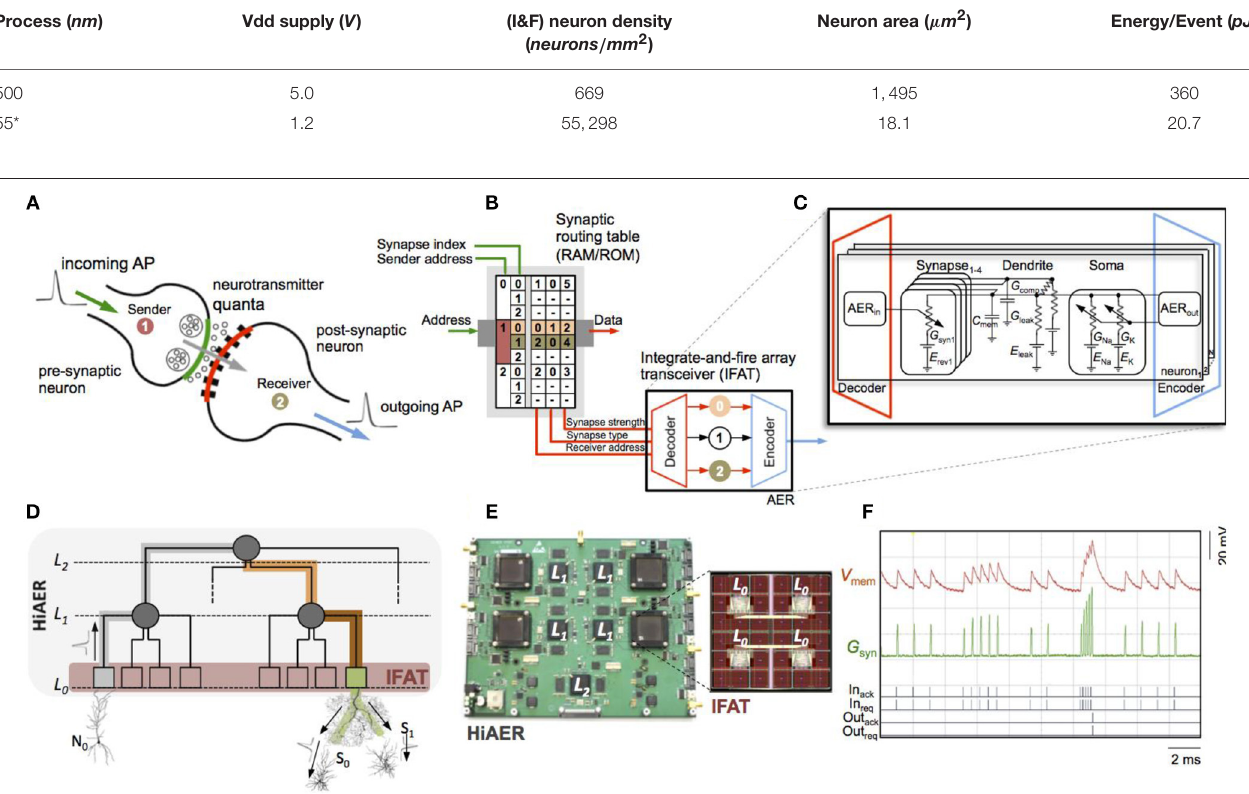
FIGURE 4 | Hierarchical address-event routing (HiAER) integrate-and-fire array transceiver (IFAT) for scalable and reconfigurable neuromorphic neocortical processing ( Broccard et al., 2017; Park et al., 2017). (A) Biophysical model of neural and synaptic dynamics. (B) Dynamically reconfigurable synaptic connectivity is implemented across IFAT arrays of addressable neurons by routing neural spike events locally through DRAM synaptic routing tables (Vogelstein et al., 2007a,b). (C) Each neural cell models conductance-based membrane dynamics in proximal and distal compartments for synaptic input with programmable axonal delay, conductance, and reversal potential ( Yu et al., 2012; Park et al., 2014). (D) Multiscale global connectivity through a hierarchical network of HiAER routing nodes (Joshi et al., 2010). (E) HiAER-IFAT board with 4 IFAT custom silicon microchips, serving 256k neurons and 256M synapses, and spanning 3 HiAER levels (L0-L2) in connectivity hierarchy (Park et al., 2017). (F) The IFAT neural array multiplexes and integrates (top traces) incoming spike synaptic events to produce outgoing spike neural events (bottom traces) (Yu et al., 2012). The most recent IFAT microchip-measured energy consumption is 22 pJ per spike event (Park et al., 2014), several orders of magnitude more efficient than emulation on CPU/GPU